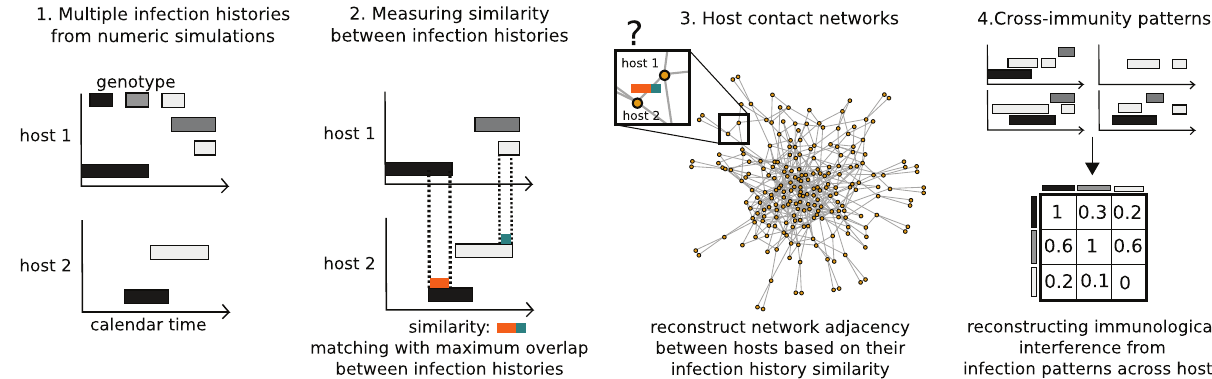
Fig 1. Diagram illustrating the workflow for reconstruction of network properties and immunological interference. In the first step, we obtain multiple infections histories of individual hosts from our simulator. Second, we calculate similarity metrics between hosts based on their multiple infection histories. Third, by comparing with simulated networks, we determine statistical associations between infection history similarity and contact network adjacency. Fourth, by calculating occurrences of infection overlaps across multiple infection histories, we obtain a matrix of immunological interference between